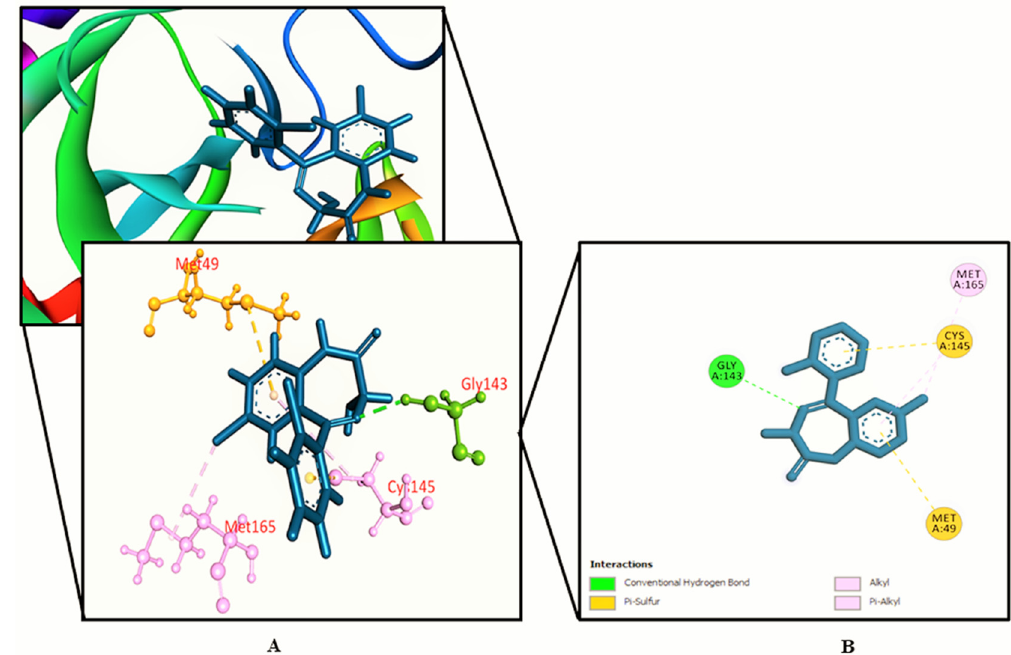
Figure 4. Lorazepam, 2TMS derivative binding the SARS-CoV-2 receptor (PDB ID: 6LU7). ( A ) A 3D representation and ( B ) 2D representation. Hydrogen bonds are displayed as green balls and sticks, hydrophobic bonds (Pi–Pi/Pi–sigma/amide–Pi interactions) are displayed as violet balls and sticks, hydrophobic bonds (Pi–alkyl/alkyl interactions stacking) are displayed as pink balls and sticks, hydrophobic bonds (Pi–sulfur) are displayed as gold balls and sticks, and carbon–hydrogen bonds are displayed as white balls and sticks.